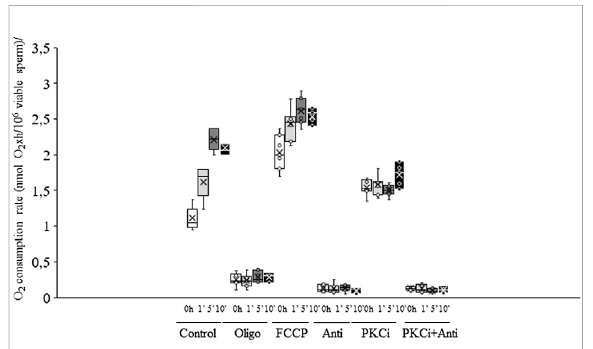
FIGURE 6 Box-and-whisker plot of the effects of antimycin A, PKCi, oligomycin A and FCCP on total O2 consumption rate. Sperm were subject to separate red LED light irradiation patterns in the presence of 1 µM antimycin A, 100 nM PKCi, 1 µM antimycin A+100 nM PKCi, 5 µM oligomycin A or 5 µM FCCP. Total O2 consumption rate, de fi ned as the sum of non-mitochondrial O2 consumption, basal respiratory rate and spare respiratory capacity, was analyzed as described in Materials and Methods section. Sperm were not irradiated (white boxes) or irradiated with redLEDlightfor1 min(lightgreyboxes),5 min(darkgreyboxes)or 10 min (black boxes) in the absence (C) or presence of 1 µM antimycin A (AA), 100 nM PKCi (P) or 1 µM antimycin A+100 nM PKCi (AA + P). Figure shows means ± S.E.M. for eight biological replicates involving eight independent samples. Asterisks inside boxes indicate means, whereas lines inside represent medians. Different superscript numbers indicate signi fi cant (p < 0.05) differences between samples pre-incubated with the same inhibitor(i.e.,Control,antimycinA,PKCiorantimycinA+PKCi)but exposed to distinct irradiation patterns (i.e., 0, 1, 5 or 10 min). Different superscript letters indicate signi fi cant (p < 0.05) differences between samples incubated with separate inhibitors (Control, antimycin A, PKCi, antimycin A + PKCi, oligomycin A or FCCP) and irradiated with the same pattern. Incubation with oligomycin A and FCCP was needed to determine basal respiration, maximal respiration, spare respiratory capacity, ATP turnover, H+ leak and non-mitochondrial O2